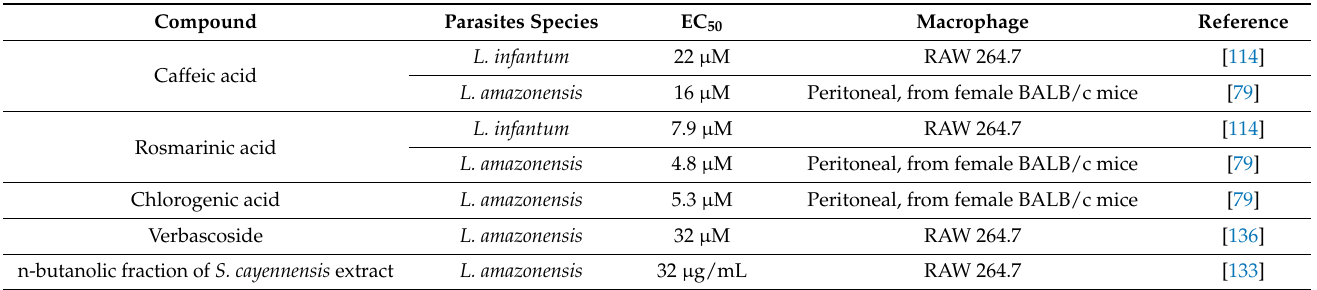
Table 10. Inhibition of intracellular amastigotes by cinnamic acid